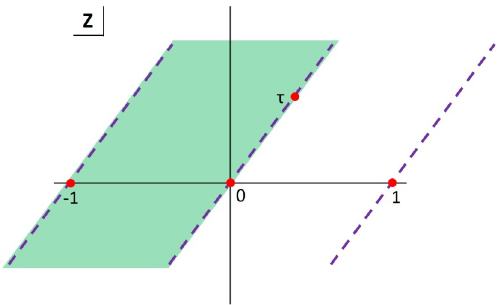
(cid:0) − 1 (cid:1) (cid:0) z (cid:1) > Im > 0 τ τ